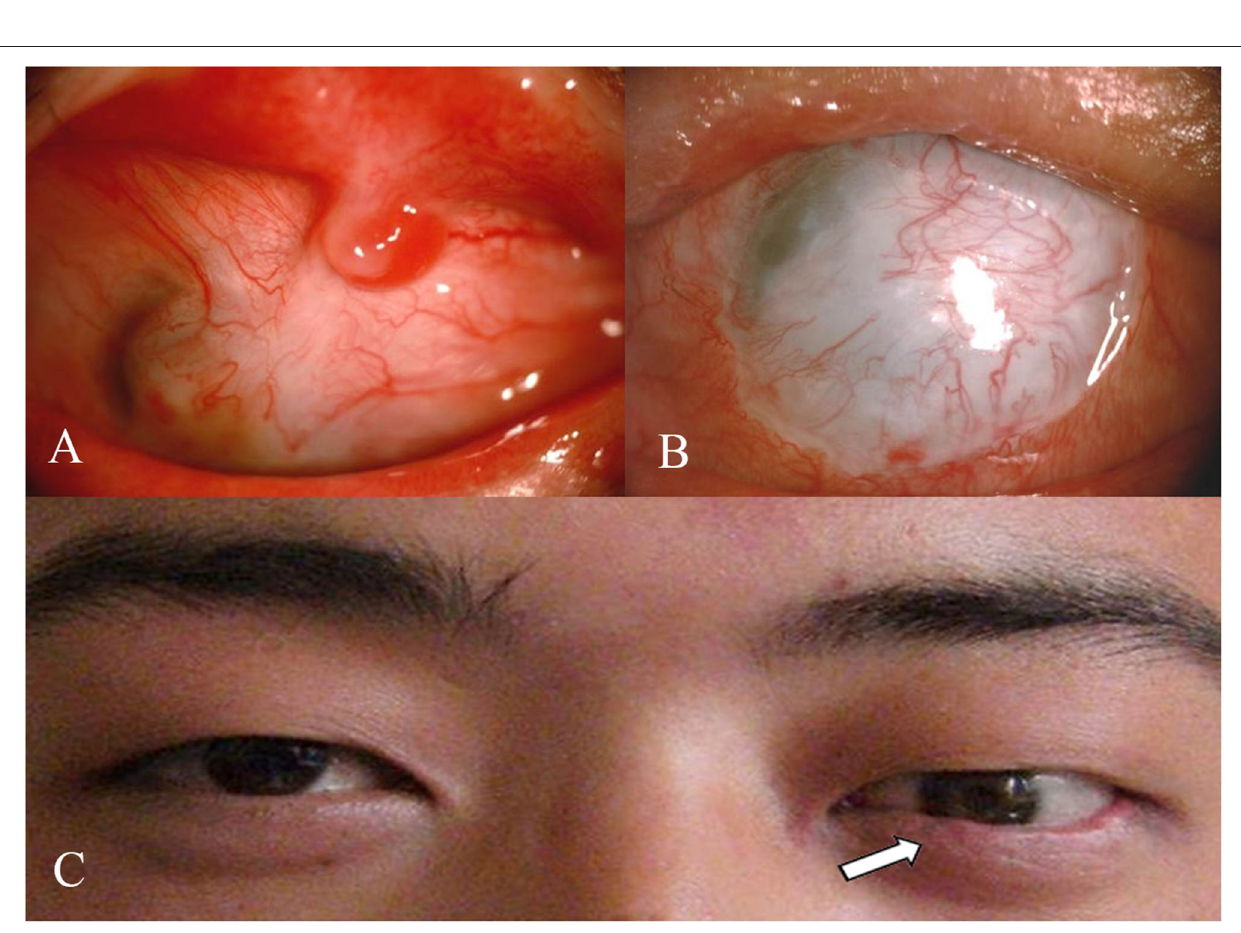
Frontiers in Medicine |